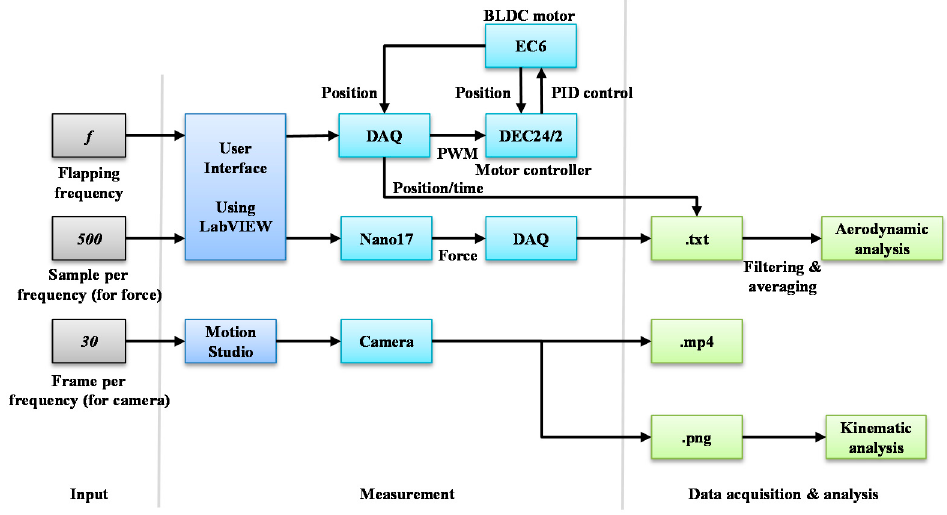
Figure 15. Flowchart of force and image data.